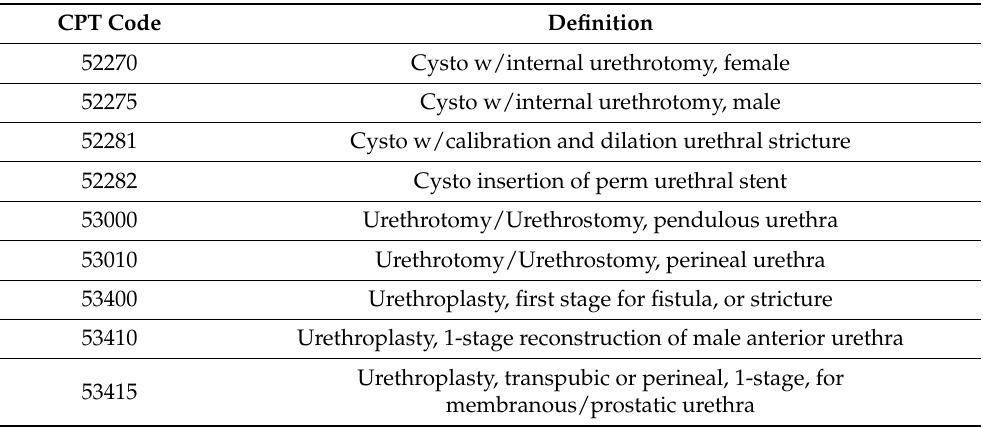
Table 1. Common Procedural Terminology Codes and Definitions.